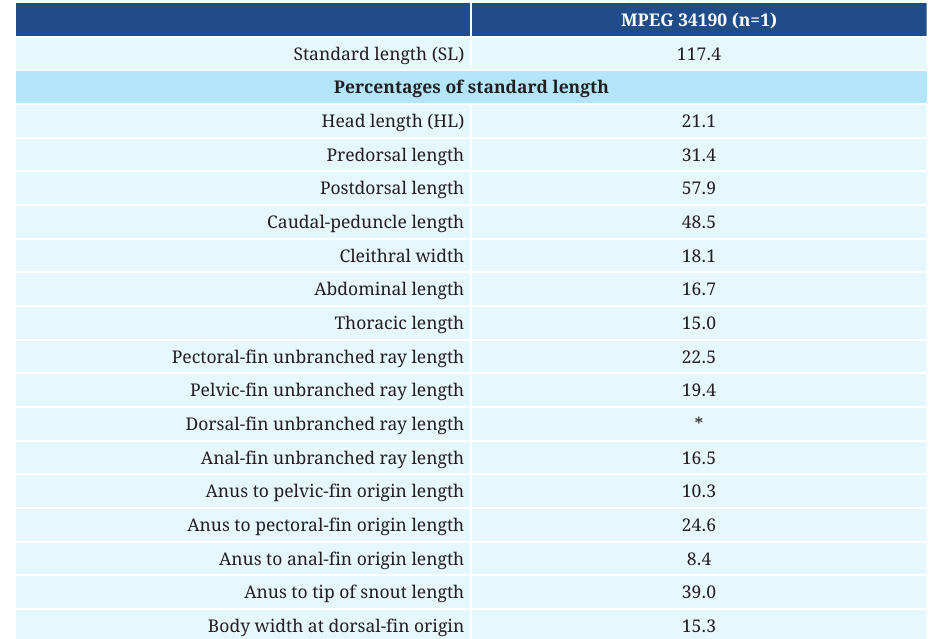
TABLE 1 | Descriptive morphometrics and meristic data of Cteniloricaria napova from the Cuminapanema River. Asterisk = broken